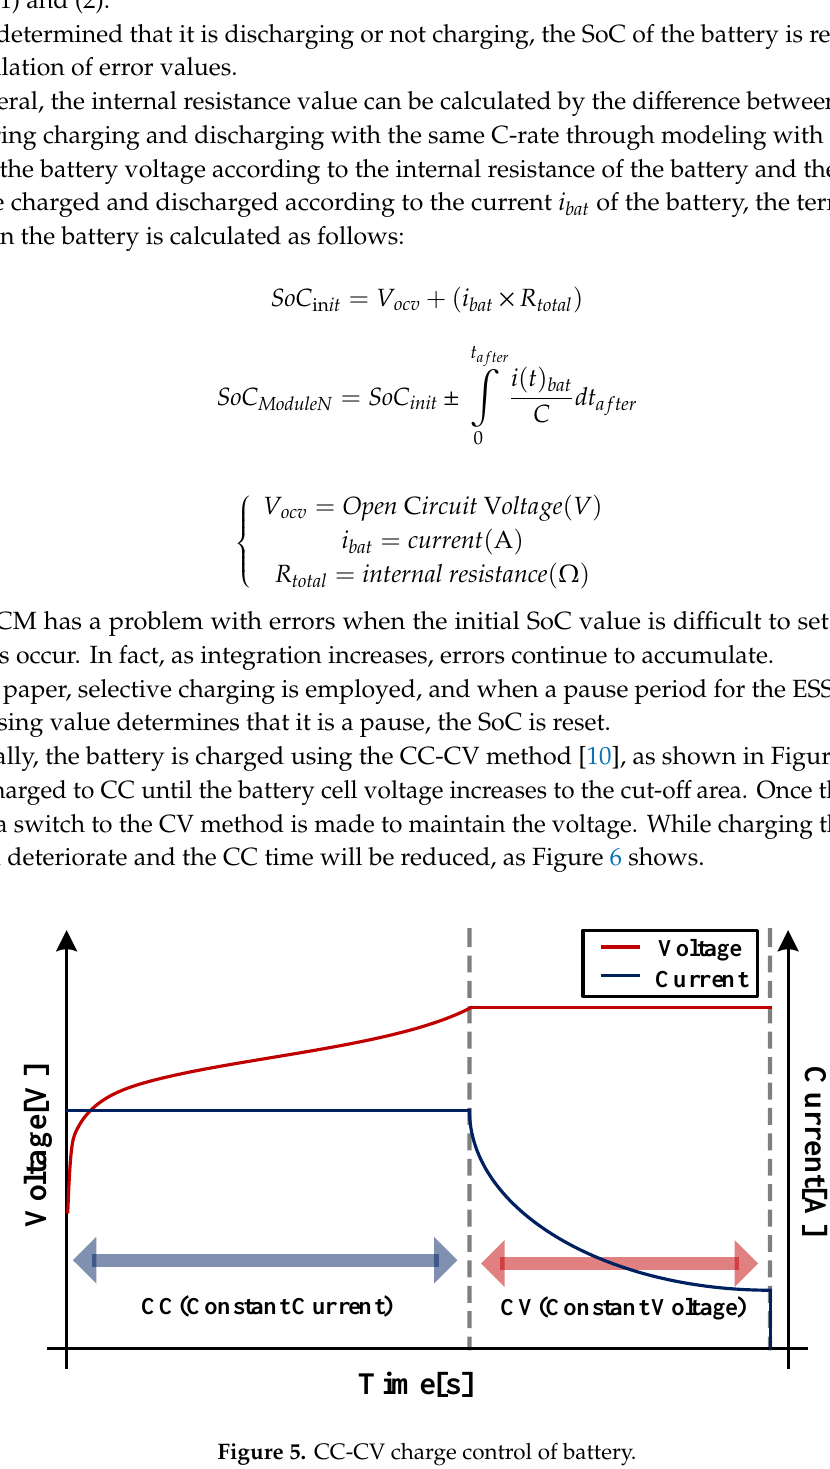
Figure 6. SoH change according to charging time. Figure 7. SoH change according to discharging time.